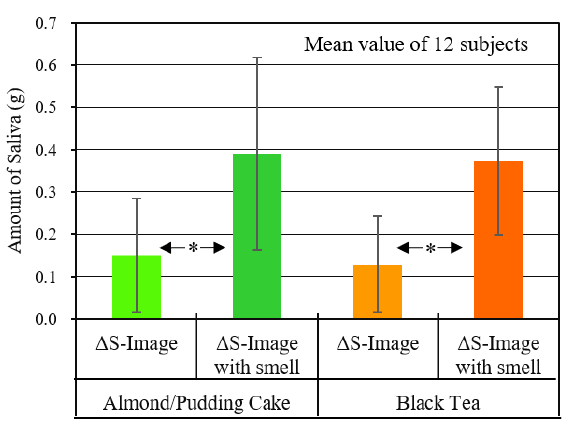
Figure 9. Changes in saliva volume after viewing content (ΔS) in STUDY 2.